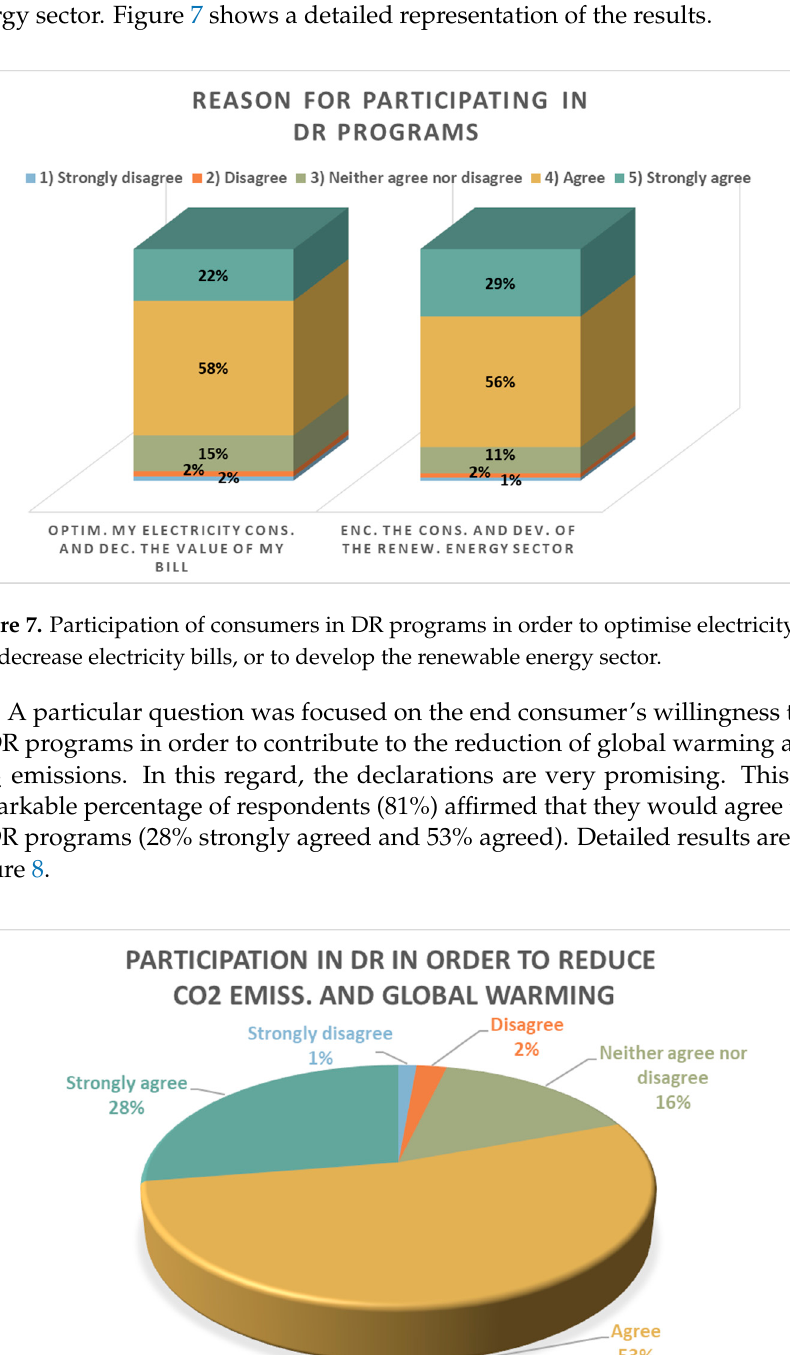
Figure 6. Consumers’ attitudes towards the Demand Response.